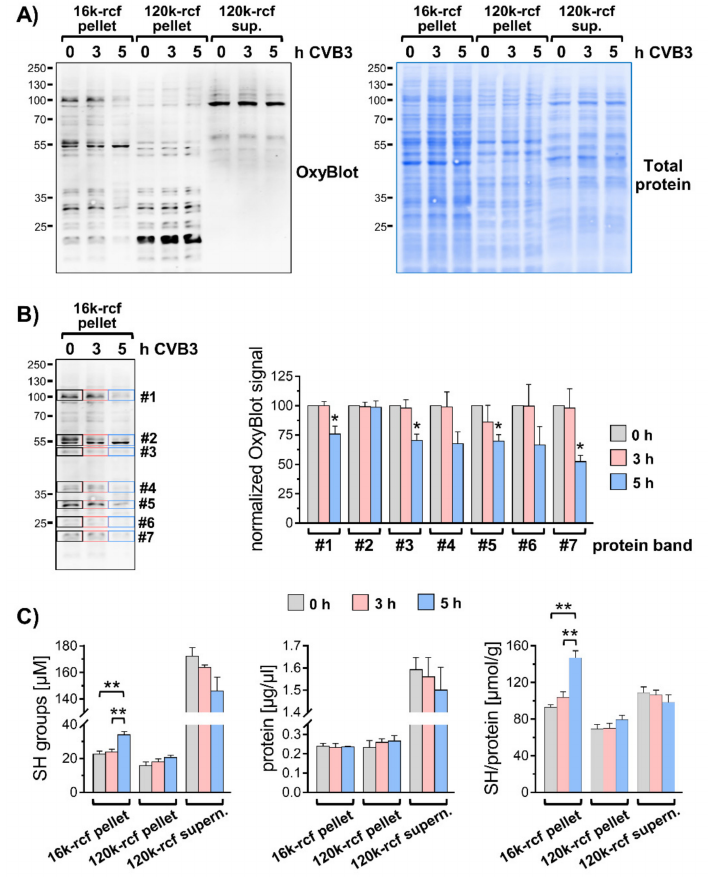
Figure 3. Analysis of oxidative modifications in subcellular fractions. ( A – C ) HeLa cells − /+ CVB3 (Nancy, MOI 1, 5 h) were disrupted in hypotonic lysis buffer using a 30-gauge syringe. Pre-cleared lysates (200 rcf for 5 min) were subjected to differential centrifugation at 16,000 rcf (16k) and 120,000 rcf (120k). ( A ) Resulting membrane pellets and supernatants were analyzed by OxyBlot and total protein staining. ( B ) Indicated bands #1–#7 of the 16k-rcf fractions were quantified ( n = 4). The bar chart depicts the CVB3-dependent change of anti-DNP immunosignals normalized to the respec- tive signal in non-infected sample (0 h = 100%), * p < 0.05. ( C ) Subcellular fractions were analyzed